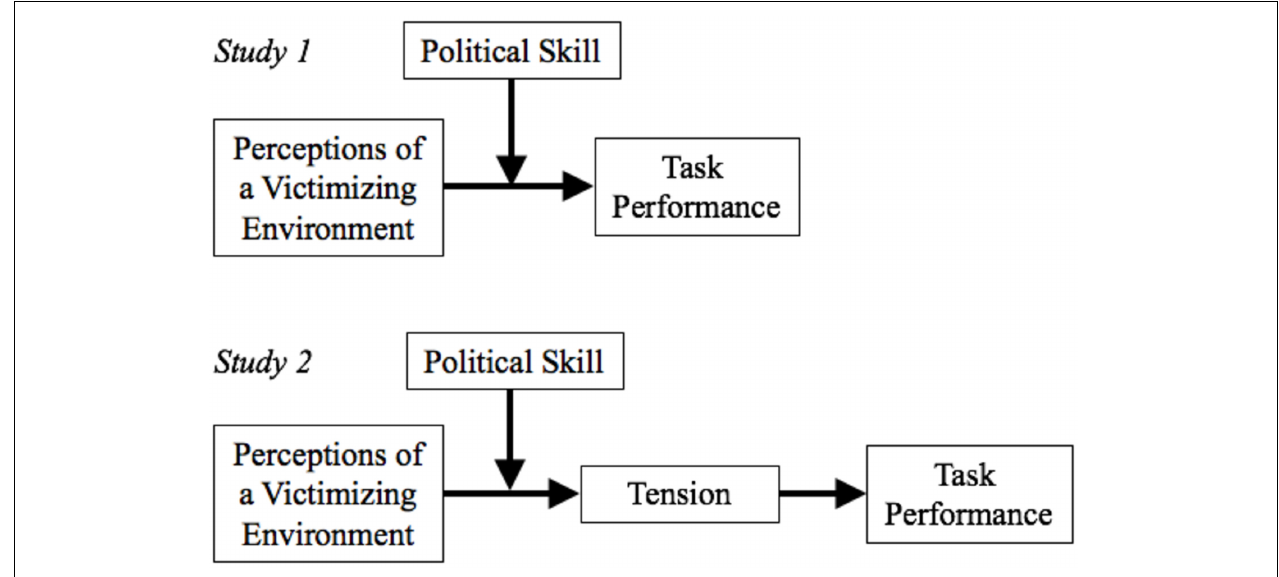
FIGURE 1 | Conceptual models for Studies 1 and